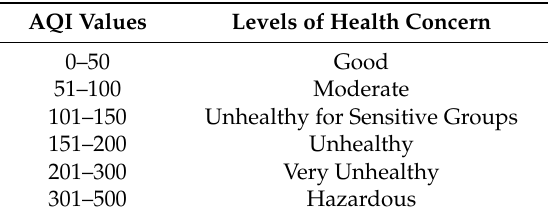
Table 1. Categories of Air Quality Index (AQI).